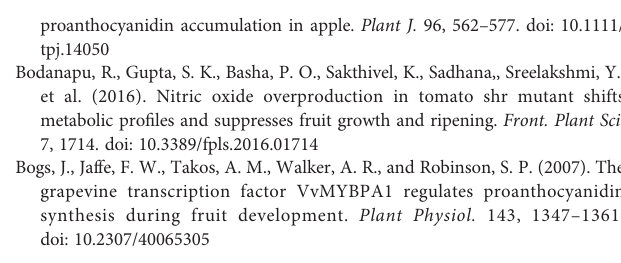
FIGURE S1 | Transcripts changes of PA biosynthesis-related genes during the process of YF (upper column) and BF (down column) ripening, respectively. The error bars represent the SDs of three independent replicates. Different letters on the bars for the same species indicate signi fi cant differences between the treatments (p < 0.05). FIGURE S2 | Effect of LbNR silencing on PA biosynthesis-related gene expression, both for YF and BF. The error bars represent the SDs of three independent replicates. The asterisks on the bars for the same species indicate signi fi cant differences between the treatments (p < 0.01). FIGURE S3 | Effect of exogenous SNP on PA biosynthesis-related gene expression, both for YF and BF. The error bars represent the SDs of three independent replicates. The asterisks on the bars for the same species indicate signi fi cant differences between the treatments. “ * ” indicates p < 0.05, and “ ** ” indicates p < 0.01. FIGURE S4 | The relationship between the release of NO and the accumulation of ABA during the process of YF (A) and BF (B) ripening, respetively. p < 0.01. FIGURE S5 | LbNCED1 silencing enhanced PA accumulation, both for YF (A) and BF (B) . The error bars represent the SDs of three independent replicates. The asterisks on the bars for the same species indicate signi fi cant differences between the treatments. “ * ” indicates p < 0.05, and “ ** ” indicates p < 0.01. FIGURE S6 | Transcriptional response of LrMYB TFs to LbNR silencing in BF. The error bars represent the SDs of three independent replicates. The asterisks on the bars for the same species indicate signi fi cant differences between the treatments. “ * ” indicates p < 0.05, and “ ** ” indicates p < 0.01. FIGURE S7 | Transcriptional response of LrMYB TFs to LbNCED1 silencing in BF. The error bars represent the SDs of three independent replicates. The asterisks on the bars for the same species indicate signi fi cant differences between the treatments. “ * ” indicates p < 0.05, and “ ** ” indicates p < 0.01. FIGURE S8 | The relationship between anthocyanins and PAs during the process of YF (A) and BF (B) ripening, respetively. p <